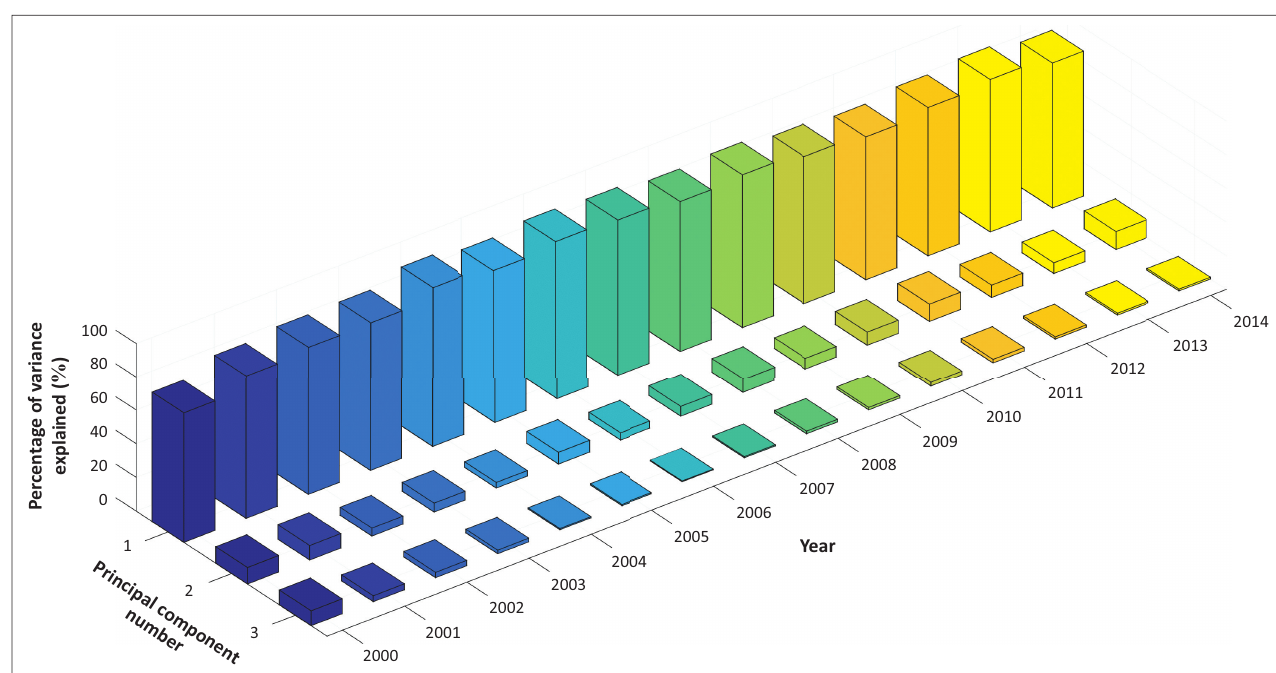
FIGURE 11: Variations in percentage of variance explained for each United States component for period: 2000–2014.